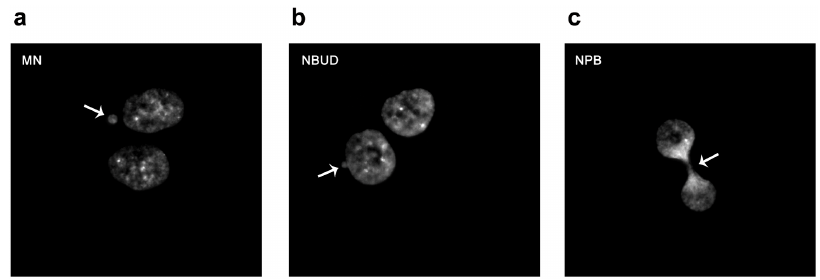
Figure 7. Example of chromosome instability biomarkers. Representative images of Bi-nucleate (BN) cells with different abnormal nuclear morphologies. The arrows denote: (a) Micronuclei (MN), (b) Nuclear Bud (NBUD), (c) Nucleoplasmic Bridge